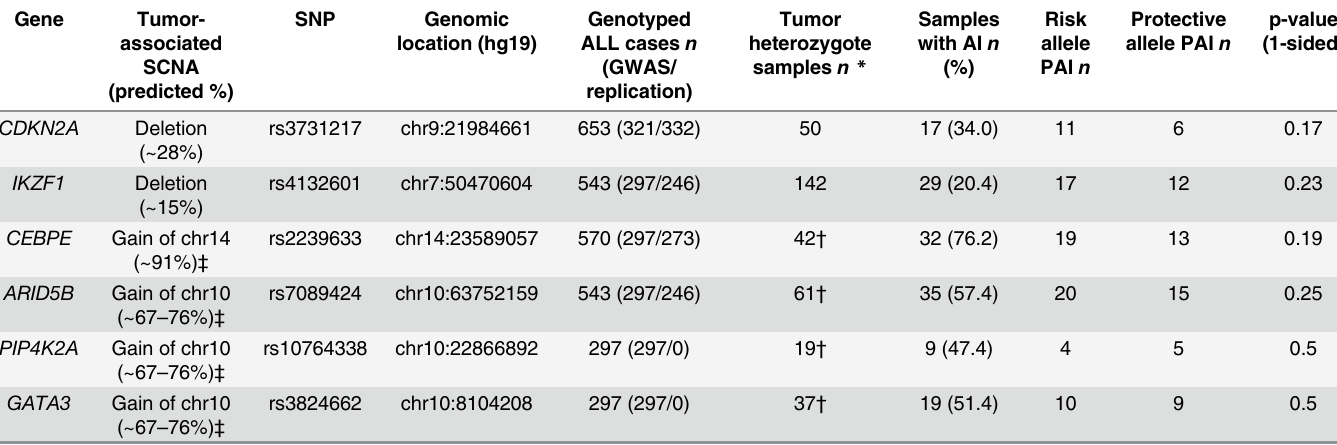
Table 1. Summary of the childhood ALL-associated SNPs investigated and the corresponding tumor DNA allelic imbalance results. Gene Tumor- associated SCNA (predicted %)